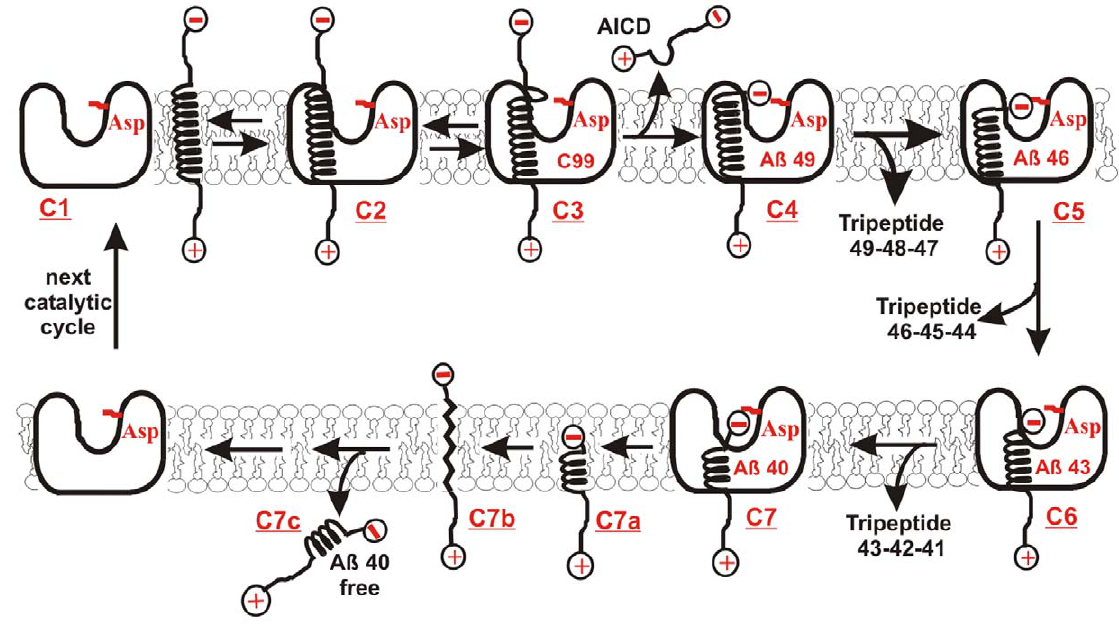
Figure 10 . Steps in the catalytic cycle of c -secretase. The model illustrates the basic biophysical principles of processive cleavages and intramembrane proteolysis [11,37,40,48,49,51]. C99 substrate can be shown as a transmembrane helix [42], while c -secretase can be shown as a bowl- shaped membrane-imbedded complex with its active site aspartates in the central aqueous cavity [11,18,19]. The initial AICD cleavage (Fig. 1) takes place between amino acids 48–49 or 49–50 [37], just under the membrane surface [42], in a dynamic section that has a tendency to destabilize the transmembrane helix ((C1- . C4), [58]). The result is a soluble AICD fragment, and a hydrophobic A b fragment with its negatively charged carboxyl- terminal trapped below the membrane surface (C3- . C4). Thus, the negatively charged carboxyl-terminal is in an energy gap that is forcing it to the interface between the hydrophobic enzyme core and the hydrophilic central aqueous cavity. The opposing force comes from the hydrogen bonds that tend to stabilize the transmembrane helix (C4). The A b peptides have a highly dynamic structure that can vary from a -helix to random-coil [51– 55,57]. Such structural changes can drag small parts of the hydrophobic A b peptides to the active site aspartates following the negatively charged carboxyl-terminus in the central aqueous cavity ((C4- . C7), [11]). Thus, the whole process can be driven by entropy and/or by repulsive forces between negative charges on the active site aspartates and the carboxyl-terminal on the nascent A b [51–54,57]. There is no need for active use of cell’s energy. The result is a sequence of processive cleavages of hydrophobic tri-peptides [48] that does not require a full exposure of the hydrophobic substrate to the aqueous catalytic site [11]. The initial cleavage at 49–50 site leads to A b 49–46–43–40 sequence, while the initial cleavage at 48–49 site leads to A b 48–45–42–38 sequence [37,40,48,49]. It is very important to realize that the most frequent end-products A b 1–40 and A b 1–42 have more than a half of the original hydrophobic transmembrane helix of C99 (C6- . C7). Such products are highly unlikely to spontaneously dissociate from the hydrophobic c -secretase to the hydrophilic extracellular space (C7c). Furthermore, the peptides are too short to form a transmembrane helix (C7a) [62], while the fully extended structures (C7b) can not be stabile due to unsatisfied hydrogen bonds in the peptide backbone [62]. For the same reasons the nascent A b -peptides (C1- . C6) can not be spontaneously released from c -secretase. The hydrophobic A b products can dissociate from c -secretase only by interacting with a carrier protein, or by forming an A b bundle as in Fig. 11. The carrier protein is expected to facilitate catalytic rates since dissociation of A b products is the rate-limiting step (Fig. 1, and Fig. S1). Thus, possible candidates for the carrier protein can be the proteins identified by He and coauthors [93], apo-lipoprotein E [5], PrP C [94], or some other surface proteins [60].